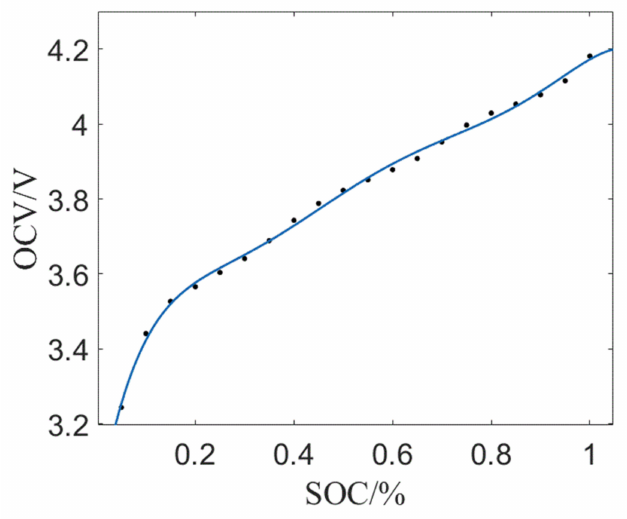
Figure 2. OCV as a function of